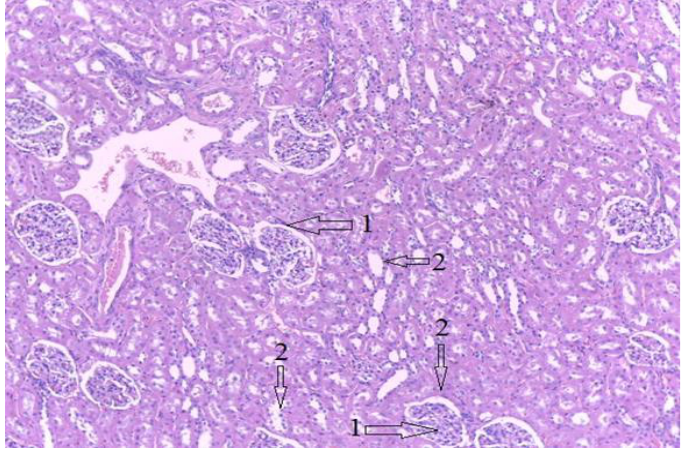
Figure 26. Kidney tissue; HE stain, 10 × 10. 1-Normal aspect of the glomeruli, 2-Normal collecting ducts.